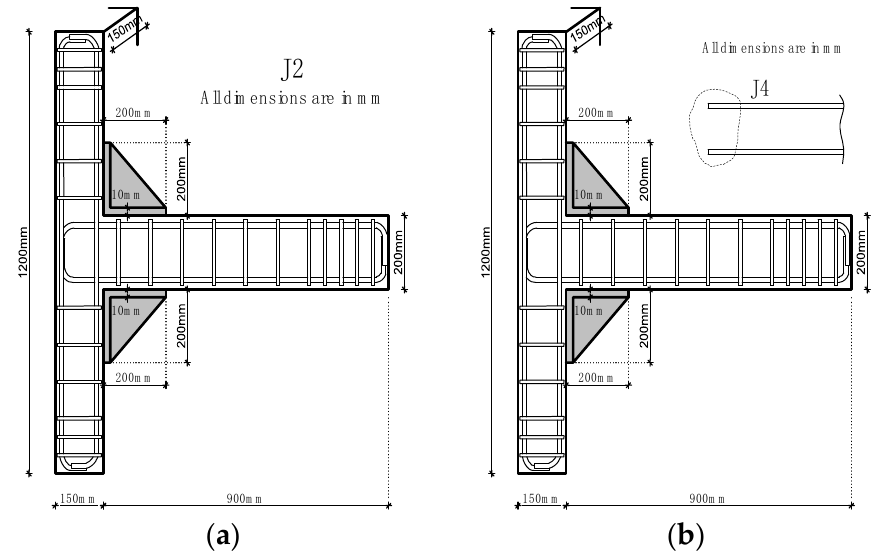
Figure 15. General layout and dimensions of the considered steel haunches. ( a ) Diagonal steel